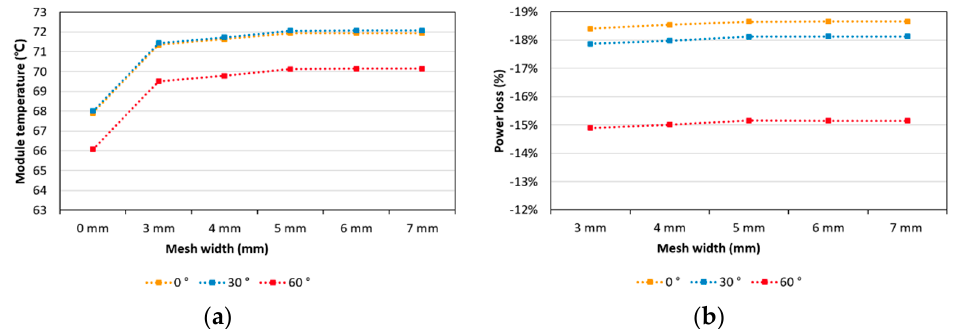
Figure 14. Performance of bifacial PV module with transparent mesh backsheet considering the module operating tempera-